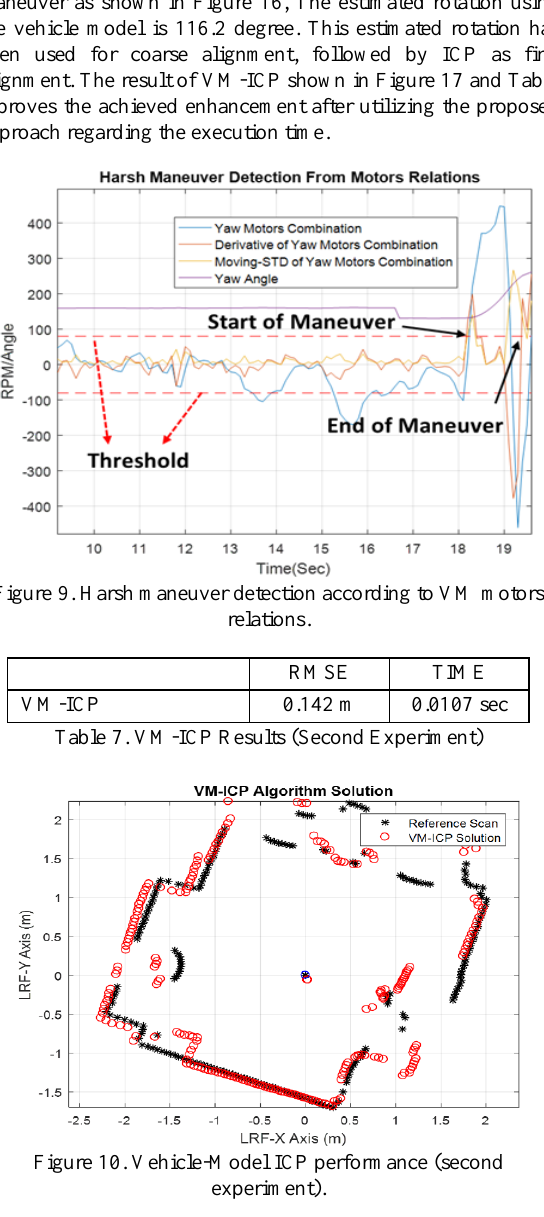
Table 5. VM/Single Level Hector SLAM performance for 10 cm Grid Size (First Experiment).